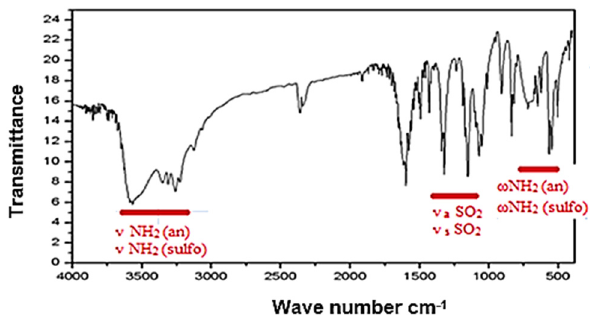
Figure 4: IR spectrum of the complex ( 2 ) in the range of 4,000 – 400 cm − 1